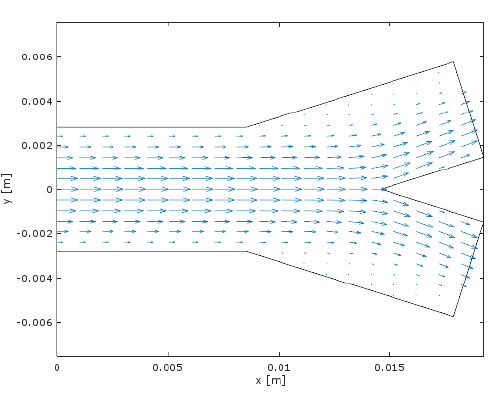
Fig. 3. The geometry of the